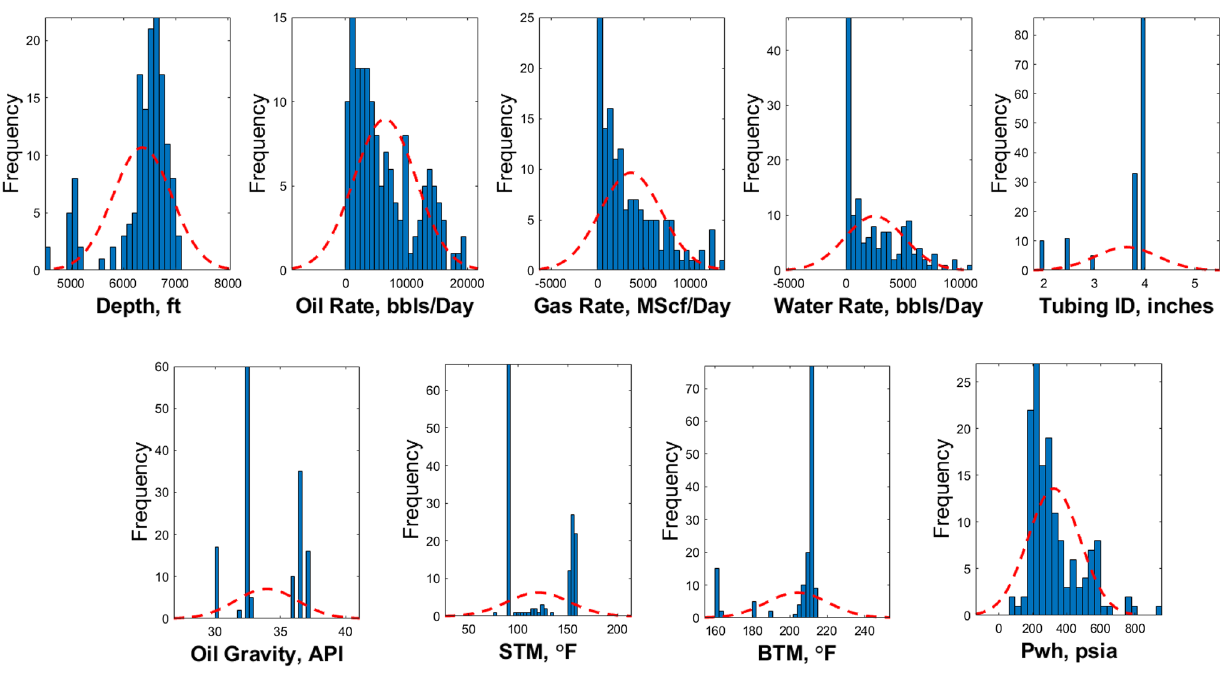
Fig. 2 Frequency histograms of training dataset (145 data points)